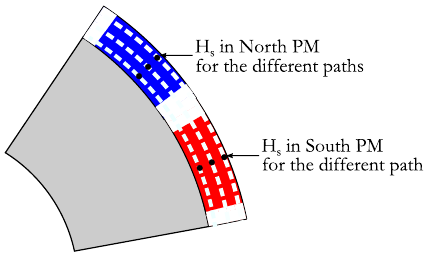
Figure 3. Tangential parallel paths in